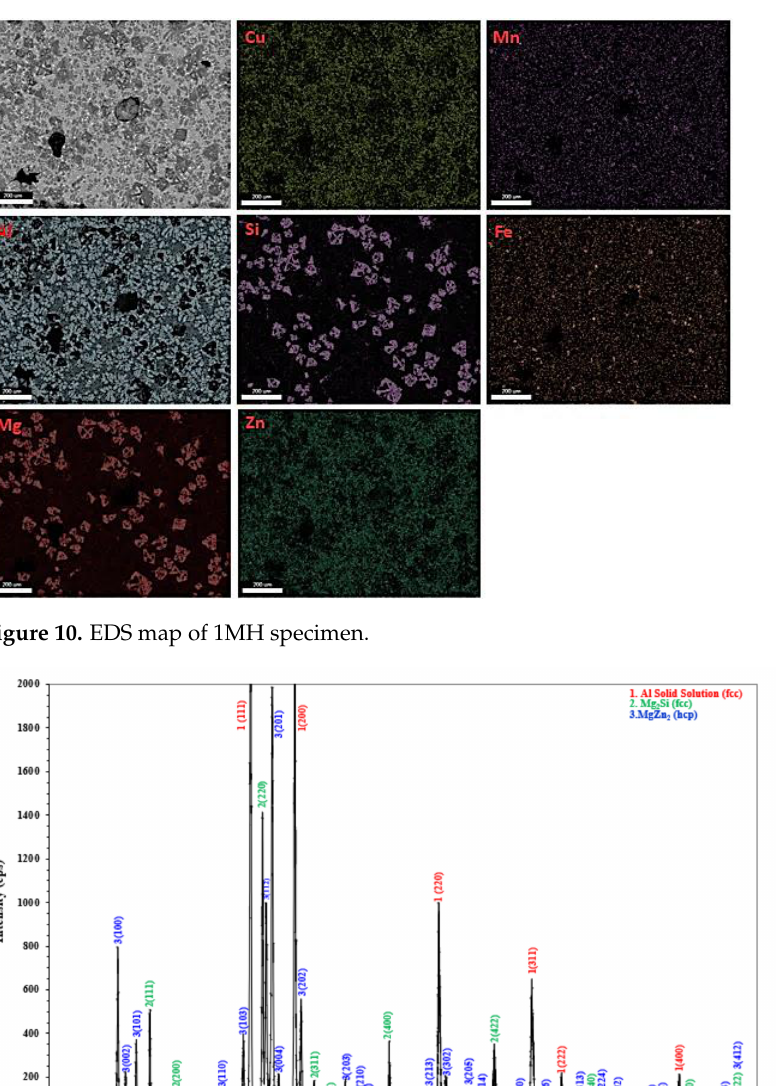
Figure 11. X- ray diffraction pattern of 1MH’ specimen.